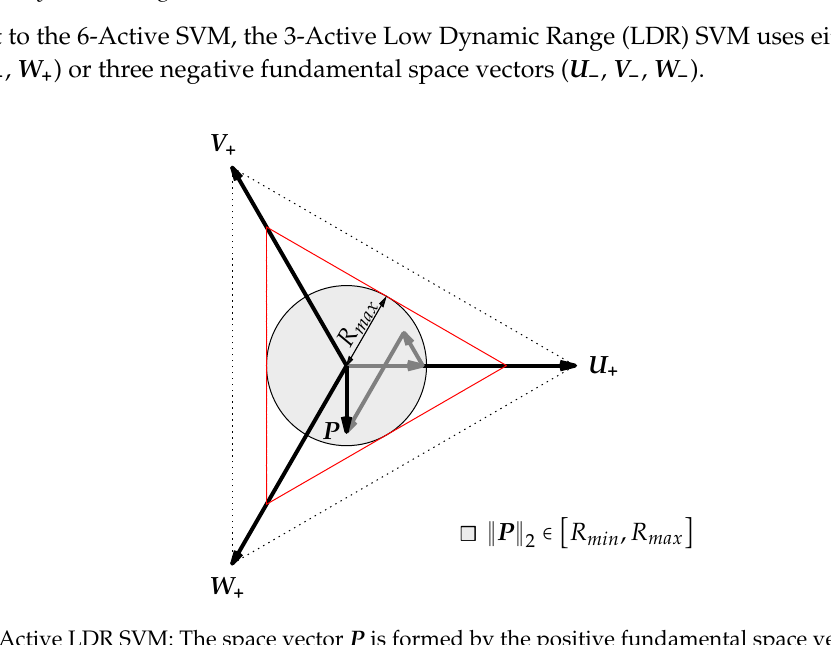
Figure 8. 3-Active LDR SVM: The space vector P is formed by the positive fundamental space vectors ( U + , V + , W + ). ( t INF =